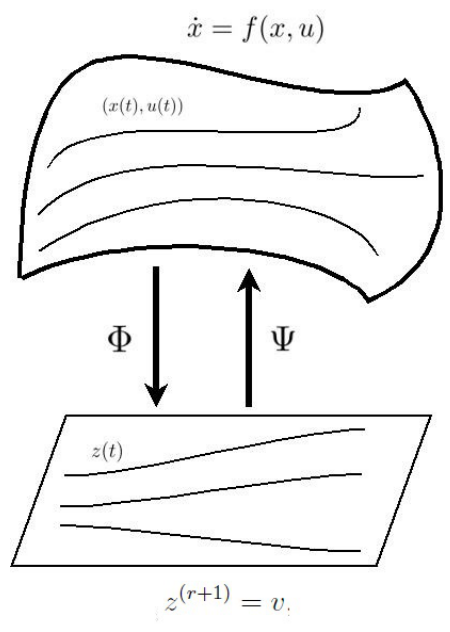
Figure 1. Representation of the flatness property (adapted from